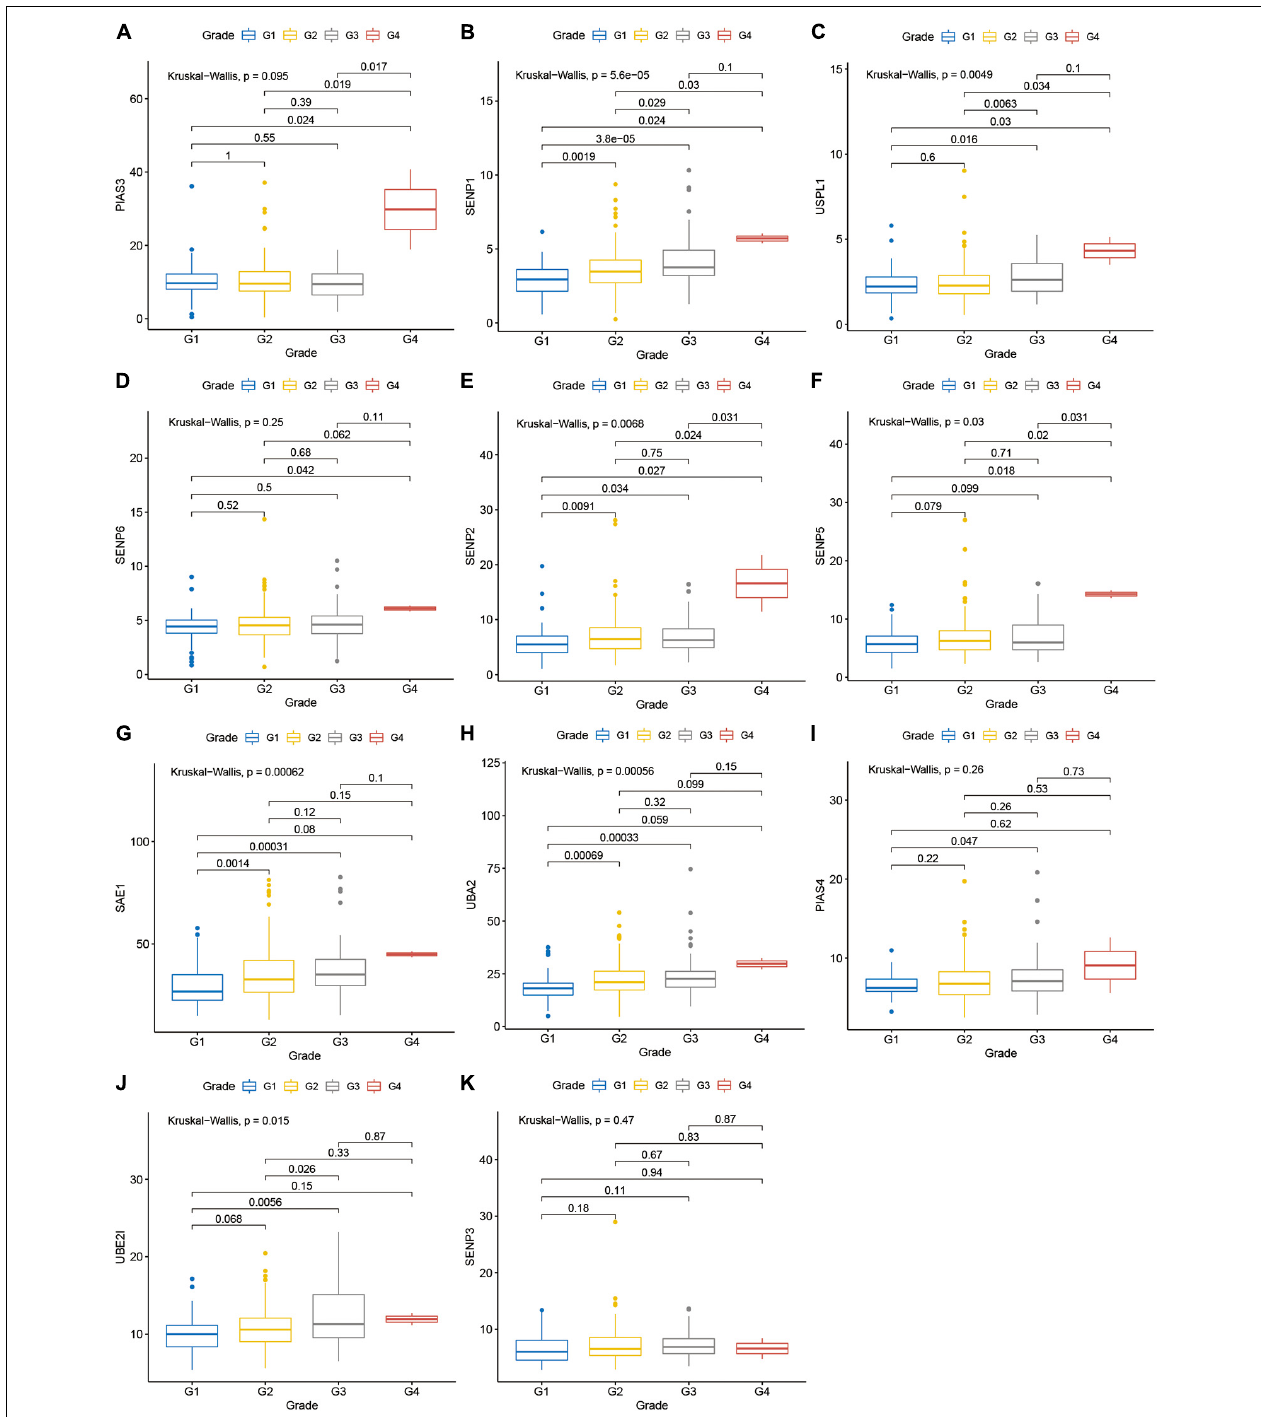
FIGURE 4 | SENP1, USPL1, SENP2, SENP5, SAE1, UBA2, and UBE2I had differential expressions with different tumor grades. (A) PIAS3; (B) SENP1; (C) USPL1; (D) SENP6; (E) SENP2; (F) SENP5; (G) SAE1; (H) UBA2; (I) PIAS4; (J) UBE2I; (K) SENP3 in different grades.